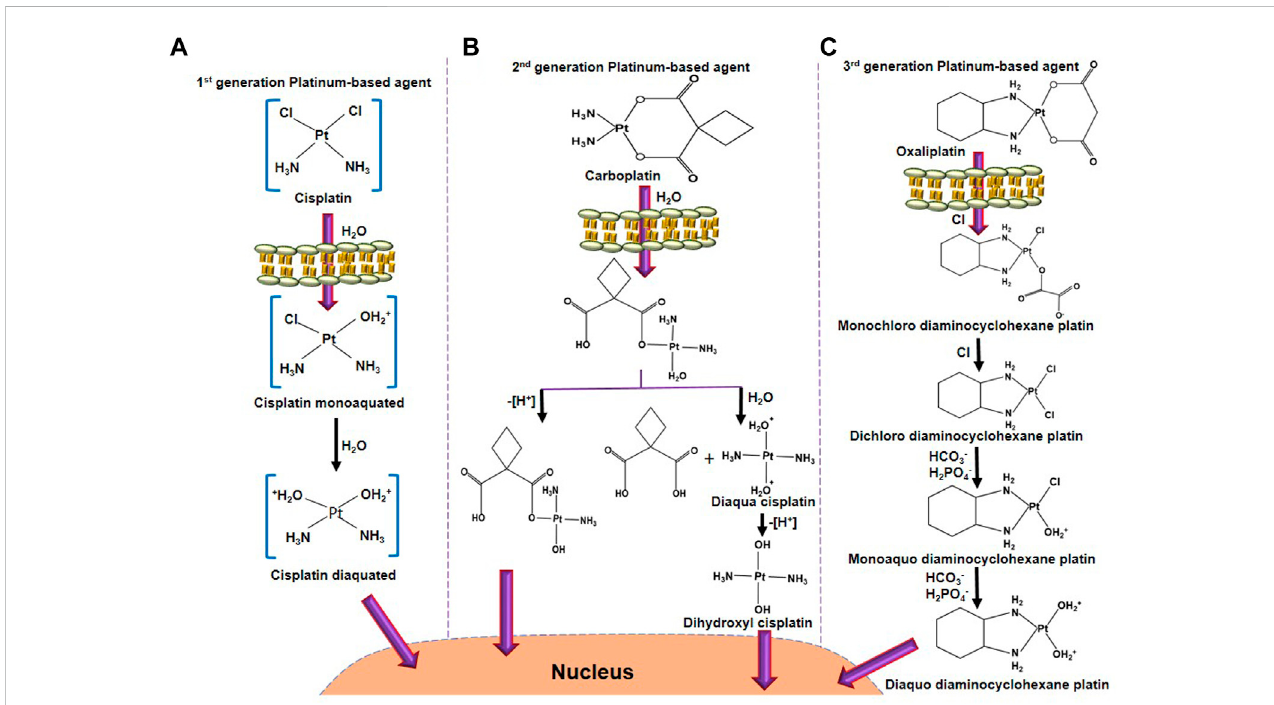
FIGURE 1 The activation process of platinum-based anticancer agents. (A) Cisplatin activation starts by exchanging one chloride molecule with a water molecule, forming cisplatin monoaquated after entering into the cell membrane. In the next step, after hydrolysis, another chloride molecule of cisplatin monoaquated was replaced to form cisplatin diaquated. This active form of cisplatin enters into the nucleus to form DNA adducts. (B) Carboplatin activation starts after hydrolysis, one bond between platinum and 1,1-cyclobutanedicarboxylate. One side oxidation will form a hydroxyl derivative of a mono-hydrolyzed carboplatinmolecule.Anotherside,furtherhydrolysiswillformdiaquacisplatin.Oxidationofdiaquacisplatinfurtherformsdihydroxylcisplatin,theactiveform of carboplatin. (C) After entering through the cell membrane, one oxygen molecule of oxaliplatin was exchanged with a chloride molecule to form monochloro diaminocyclohexane platin. A similar reaction occurs, leaving chloride molecules to form dichloro diaminocyclohexane platin. Further, interaction with HCO 3 − and H 2 PO 4 − forms monoaquo diaminocyclohexane platins. A similar bicarbonation and phosphorylation forms diaquo diaminocyclohexane platin, which is the active form of oxaliplatin. This active oxaliplatin derivative enters the nucleus to form DNA